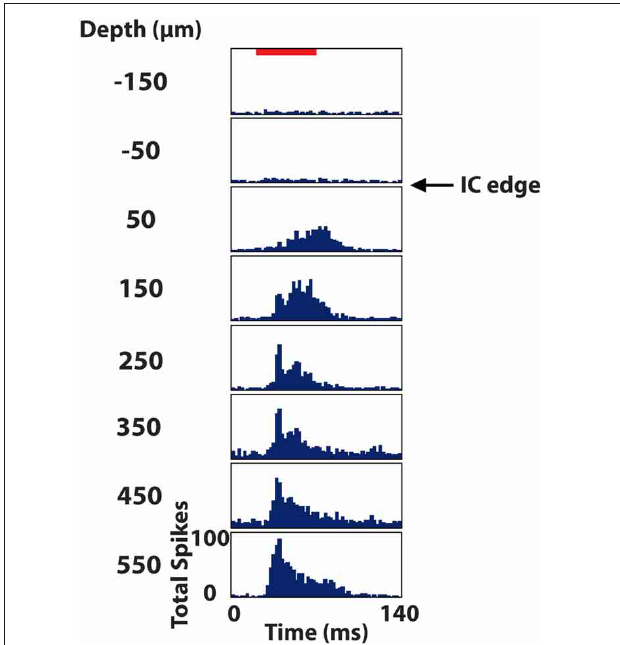
FIGURE 6 | Post stimulus time histograms of eight sites in the inferior colliculus (IC) in response to 100 trials of broadband noise (70dB SPL, 6 octaves centered at 5kHz). The red bar corresponds to the acoustic stimulus (60ms duration) and depths are labeled relative to the superficial edge of the IC, which was approximated as the center point between the last electrode site responding significantly to the stimulus and the next site outside of the IC.